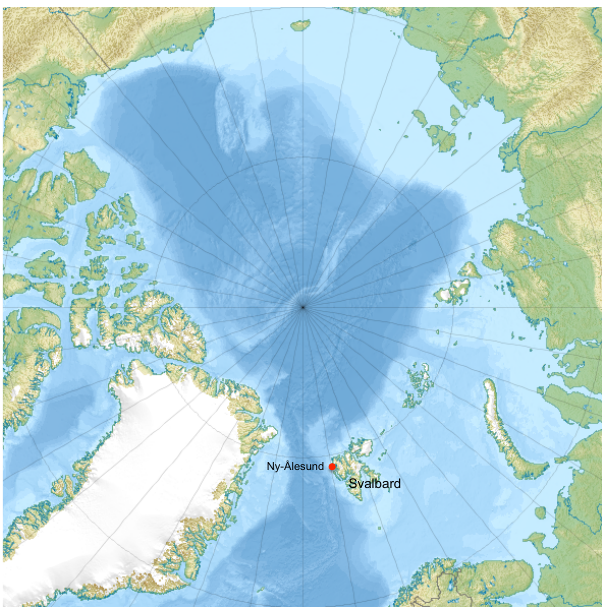
Fig. 9. Map of the Arctic. Red dot denotes the location of the study site (Kongsfjorden, Ny- ˚Alesund) on the north-west coast of Spitsbergen, the largest island of the Svalbard archipelago. Source: Wikipedia.